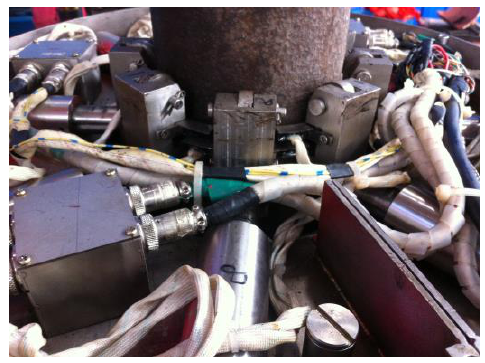
Figure 14. The lift-off-tolerant MFL probing system.